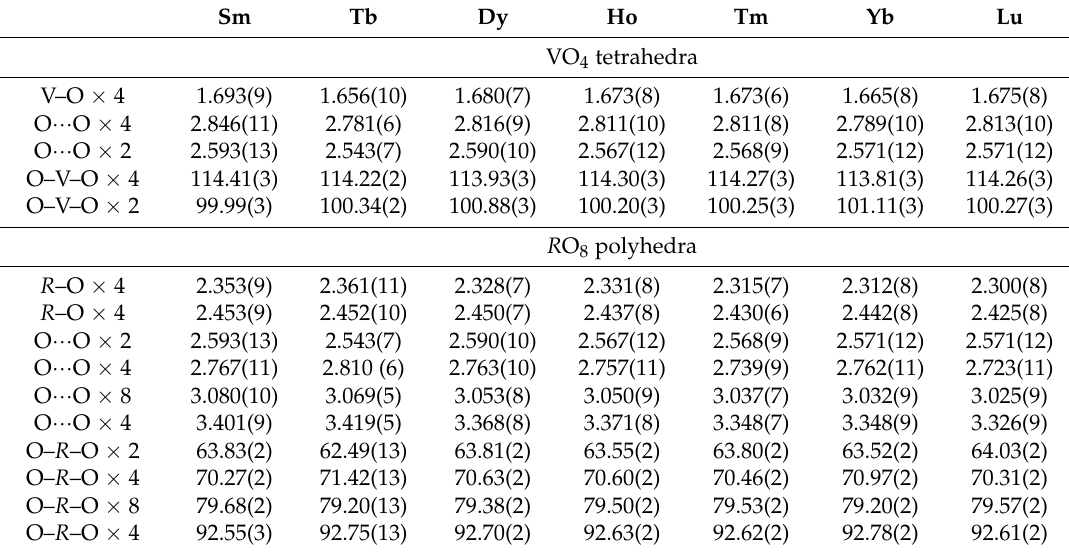
Table 2. Selected interatomic distances (Å) and angles ( o ) in Y 0.5 R 0.5 VO 4 structures.